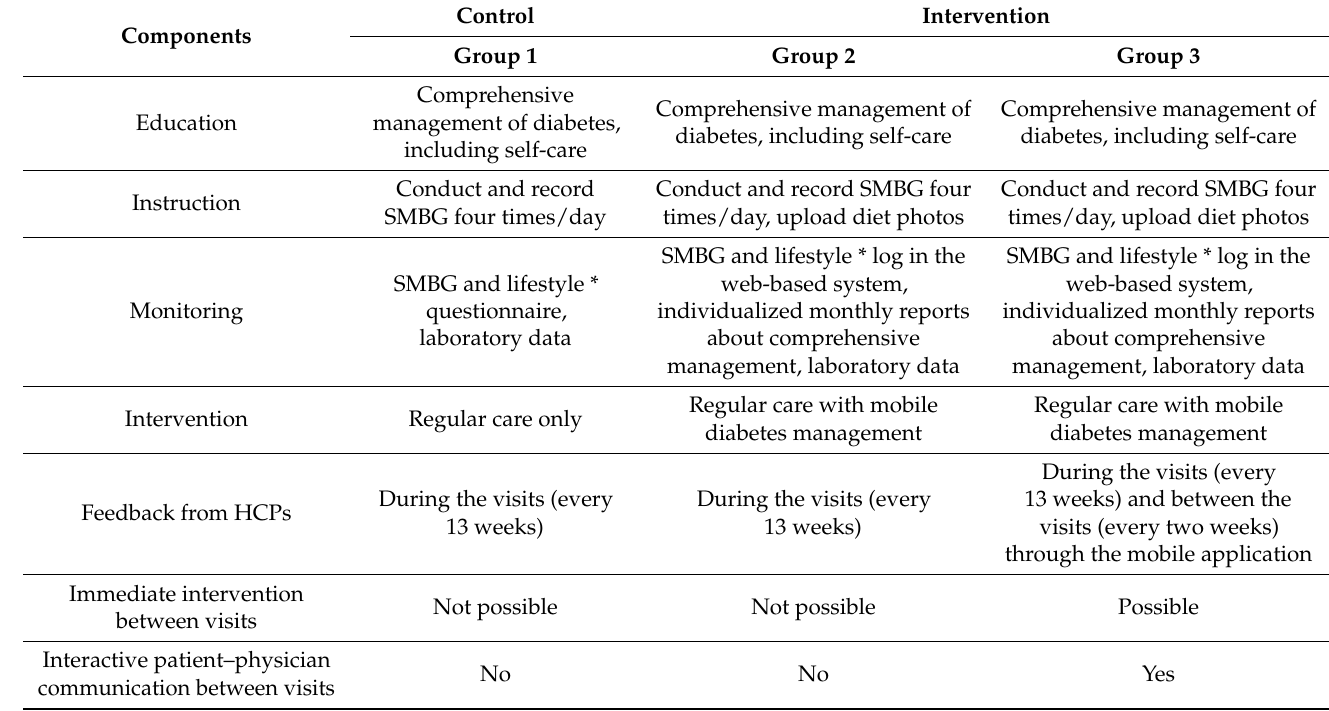
Table 1. Comparison of intervention protocols for each